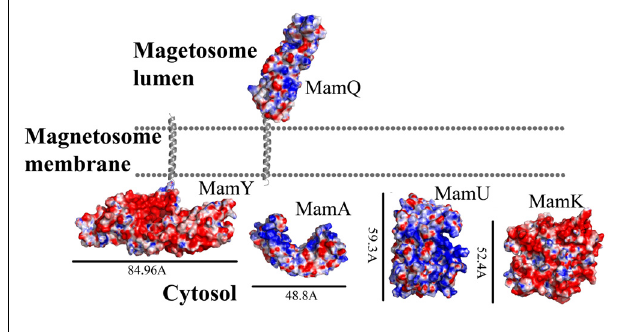
FIGURE 2 | Electrostatic density representation of proteins involved in protein sorting, magnetosome membrane invagination, and magnetosome chain assembly. Negative charges are in red and positive charges are in blue. Predictions of anchoring transmembrane helices are in gray. Black bars define the protein size in angstroms. M. gryphiswaldense MSR-1 MamA structure was determent by X-ray